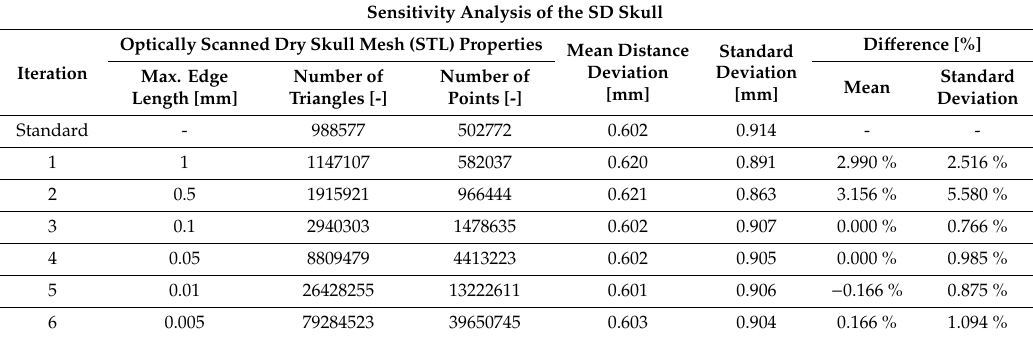
Table 5. The mesh sensitivity analysis of the SD skull surface with respect to the segmented SD head